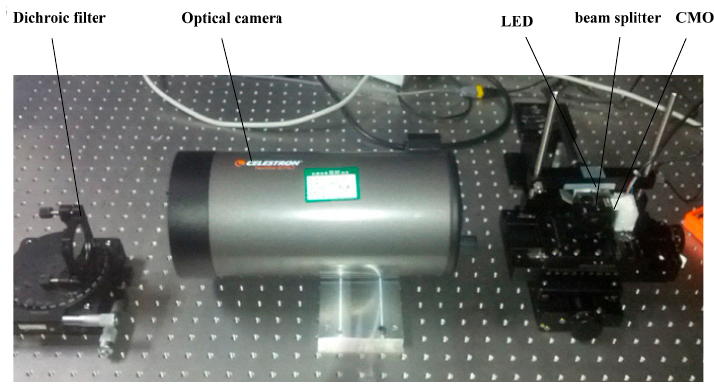
Figure 12. Experimental setup.